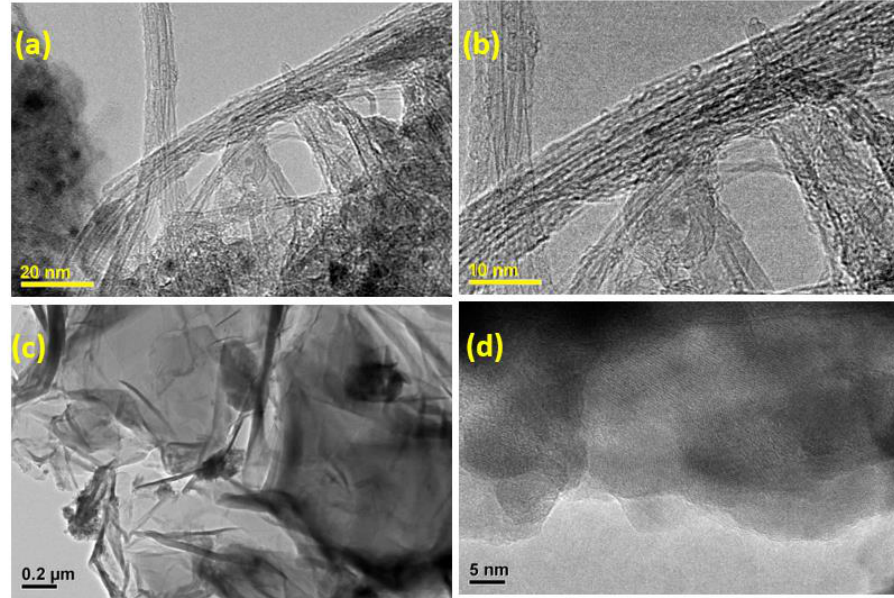
Figure 3. TEM image of ( a , b ) CNTs-HAP and ( c , d ) GR-HAP.